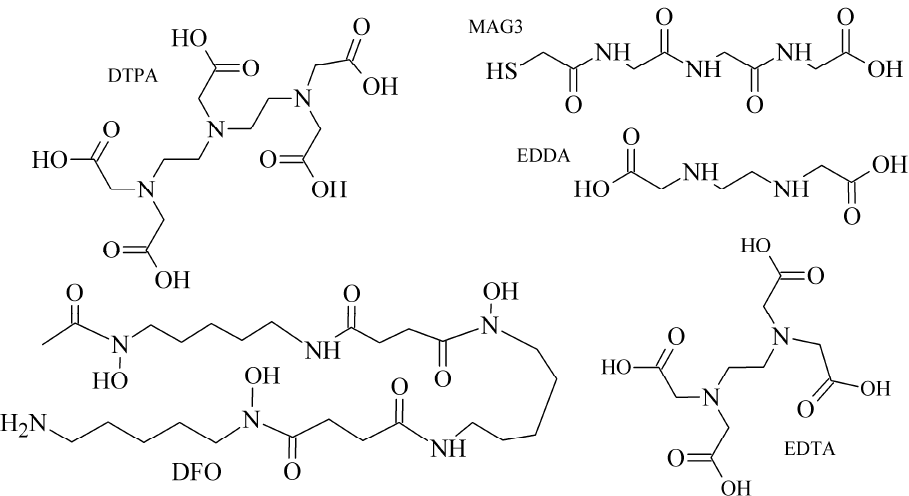
Figure 2. Chemical structures of the most common acyclic chelators as a base of BFCA.